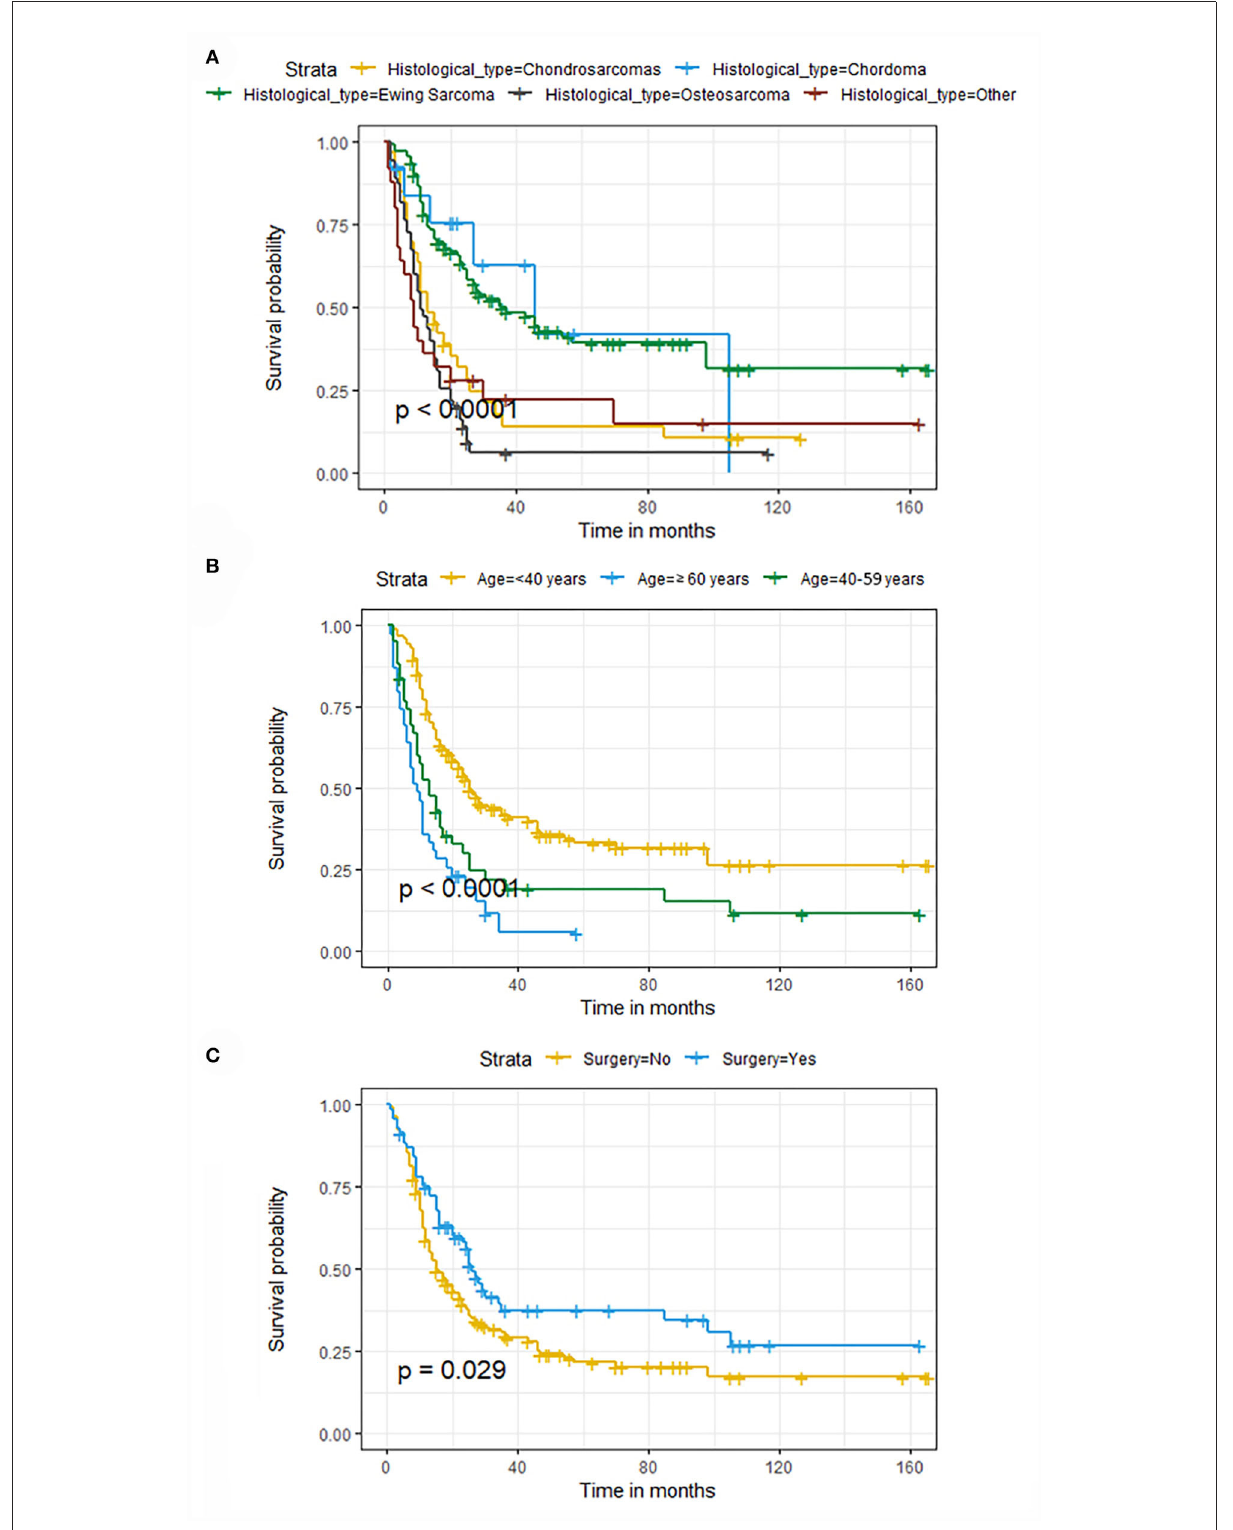
FIGURE7 Kaplan–Meier survival curves of variables were performed for patients with POSNs with DM. (A) Histological type, (B) age, (C)